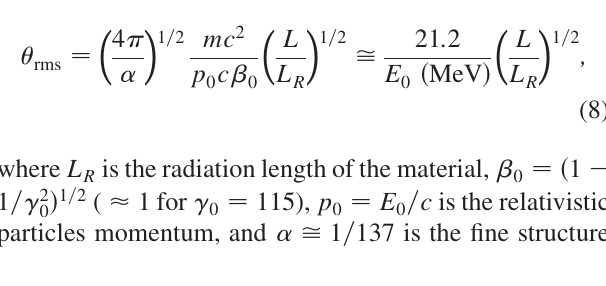
FIG. 6. (Color) Profiles of the beam dispersed in energy at the end of the beam line ( s ¼ 31 m in Fig. 1) with the energy slit allowing either six microbunches (red line) or seven micro- bunches (dashed green line, shifted up in amplitude by 1000 a.u.), which demonstrates the ability to choose the number of microbunches in the bunch train. Variations in the micro- bunches amplitudes are due to slightly different beam